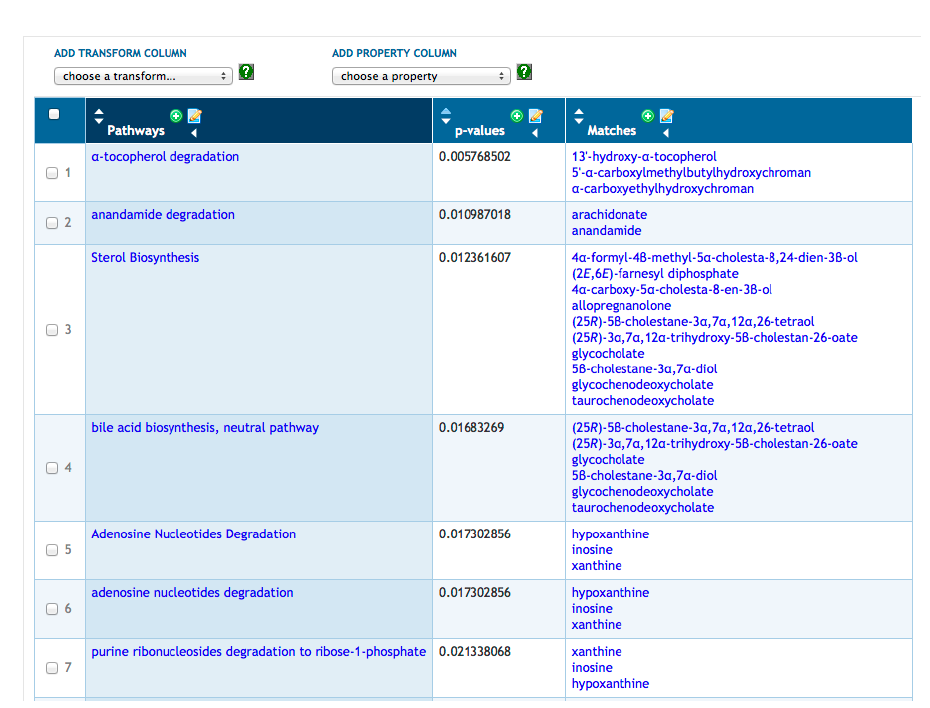
Figure 3. SmartTable containing results of running a metabolic pathway enrichment analysis on the metabolite SmartTable in Figure